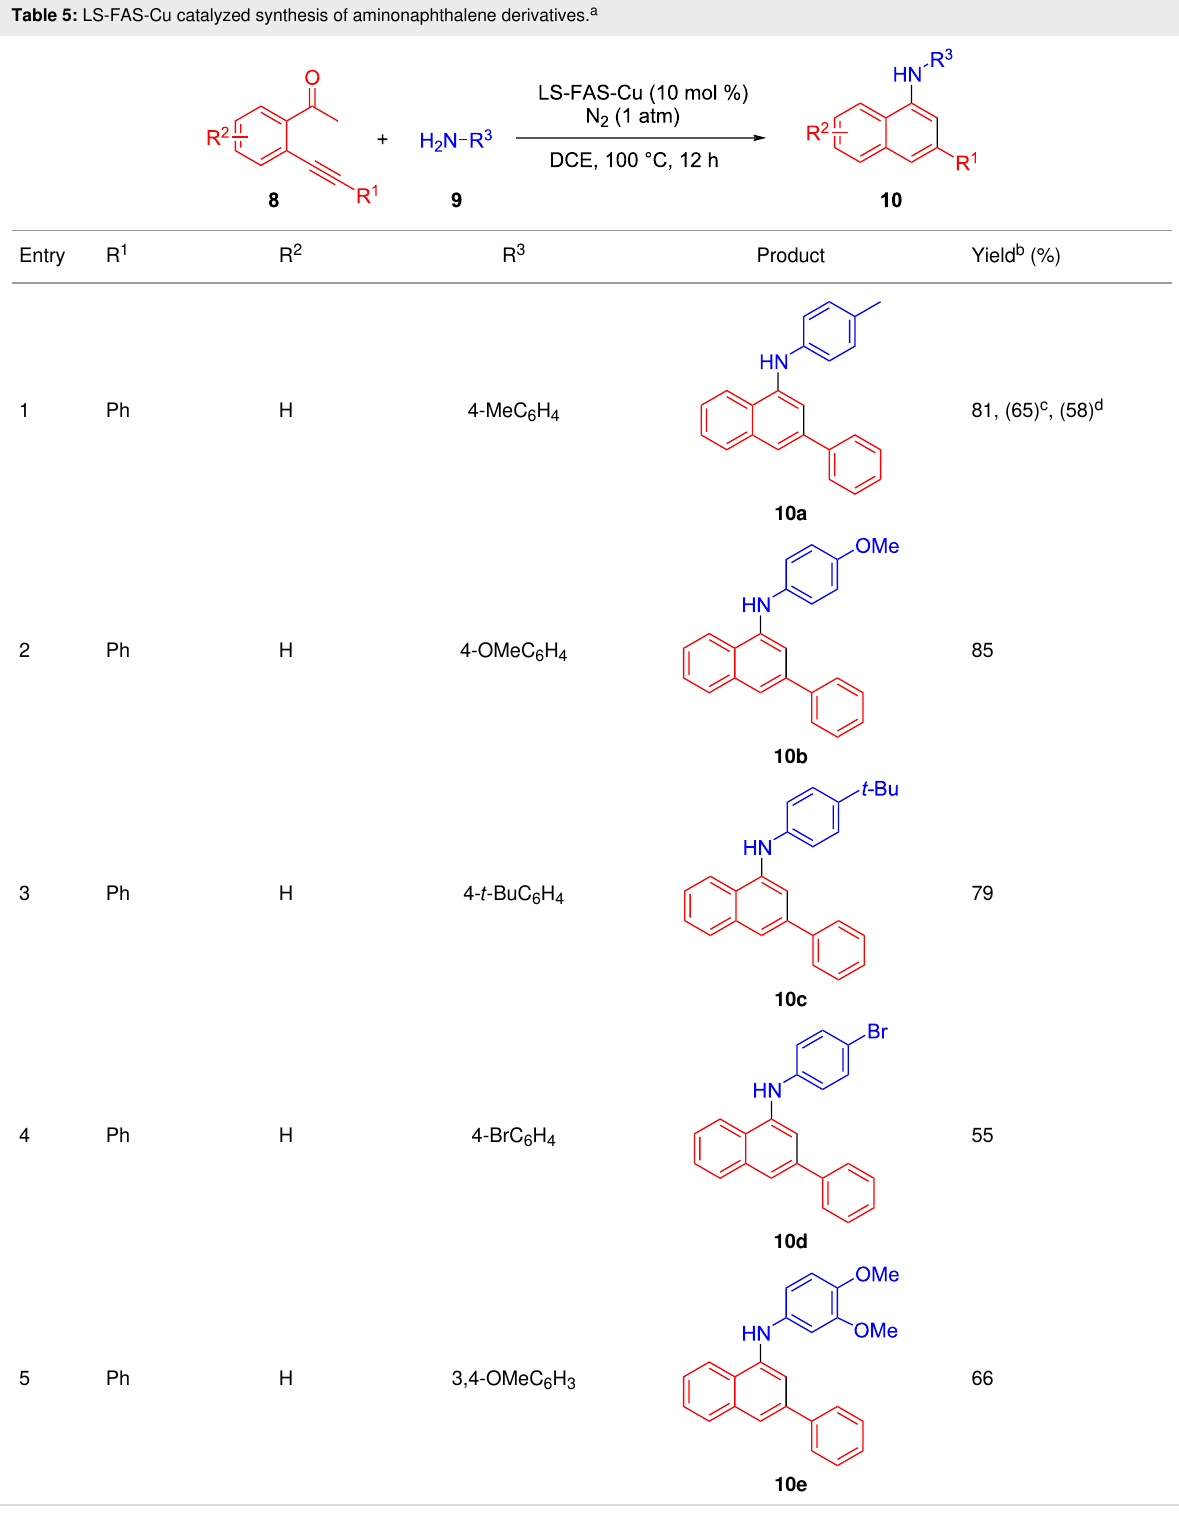
Table 5: LS-FAS-Cu catalyzed synthesis of aminonaphthalene derivatives.